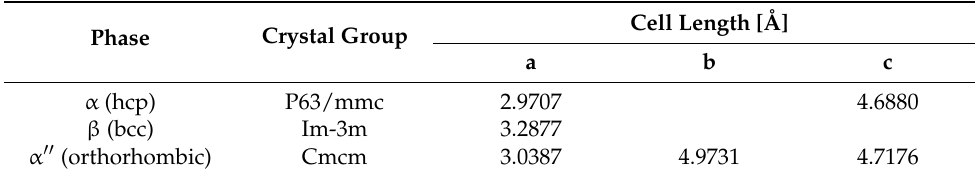
Table 1. Crystal structure and R.T. lattice parameters of α , β and α (cid:48)(cid:48) -martensite in homogenized and quenched Ti-6264. Cell Length [Å] Phase Crystal Group a b c α (hcp) P63/mmc 2.9707 4.6880 β (bcc) Im-3m 3.2877 α (cid:48)(cid:48) (orthorhombic) Cmcm 3.0387 4.9731